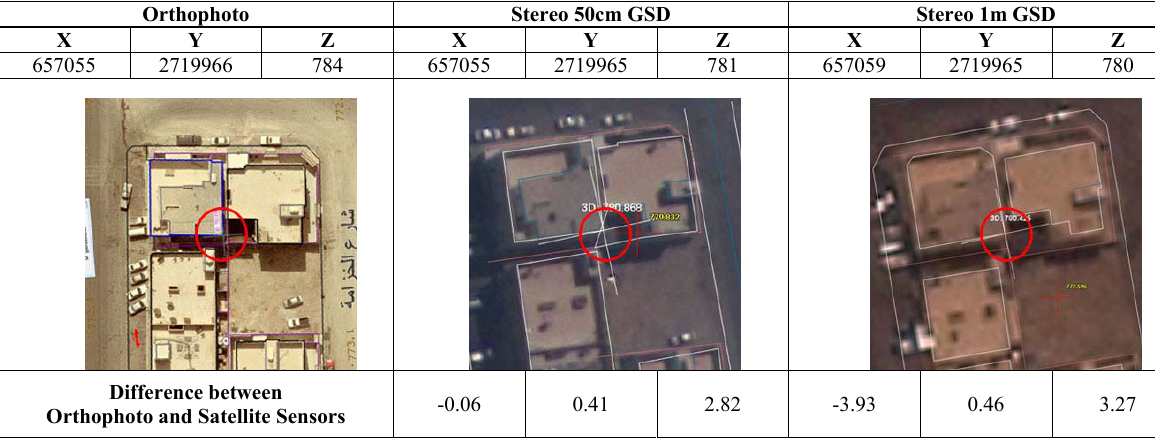
Table 1a. Showing capturing of building corner based on different resolutions of Stereopairs